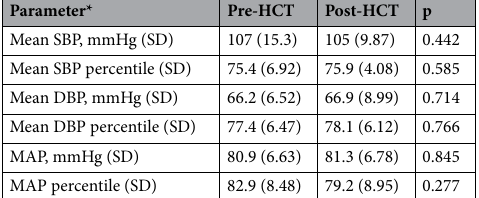
Table 6. ABPM parameters in the pre-HCT group compared with the post-HCT group. *n of measurements